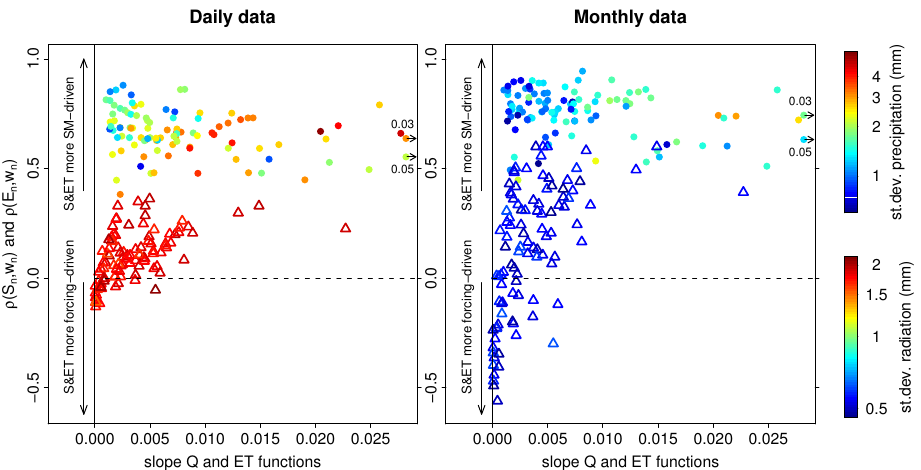
Fig. 9. Soil moisture-streamflow (dots) and soil moisture-ET (triangles) coupling strengths, ρ (Q n ,w n ) and ρ (E n ,w n ) , respectively, plotted against the respective runoff and ET function slope (computed as described in Section 4.4.2) for daily and monthly averaged data. The colour coding denotes the variance of the weighted precipitation sum precipitation ( P ∗ n ) and of radiation, respectively. All involved quantities computed as means from May–September. Points that do not fit with the range of the x and/or y axis are also included together with an arrow pointing in the direction of their actual location and the true value displayed next to it.